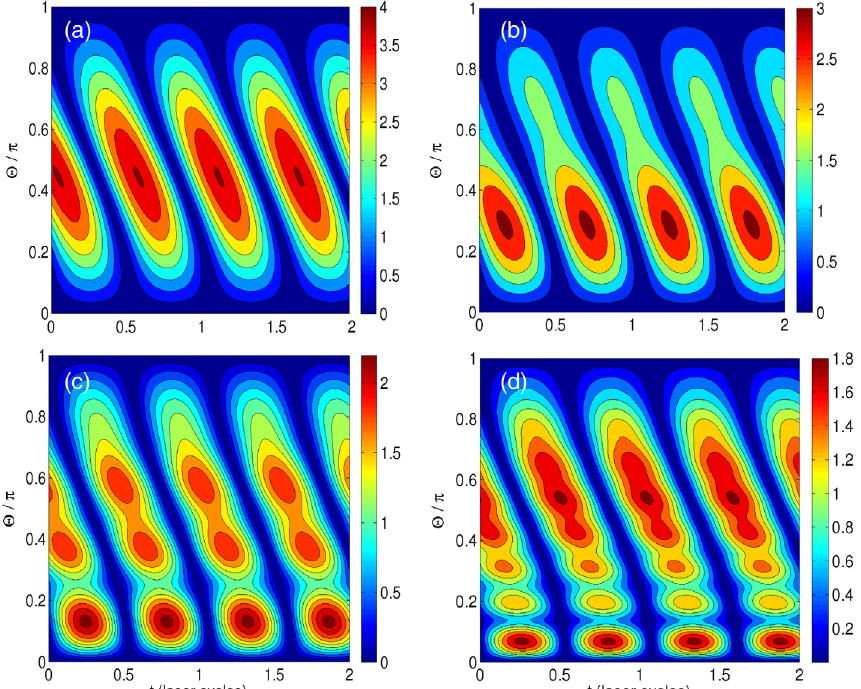
FIG. 4. Absolute value of the radial electric field for a 100 times overdense droplet with R ¼ 100 nm (a), 200 nm (b), 500 nm (c), and 1 micron (d) in an incident plane wave of wavelength λ ¼ 800 nm as a function of time and angle on the surface. The color scale indicates the enhancement factor of the incident electric field E 0 , for a constant plane wave